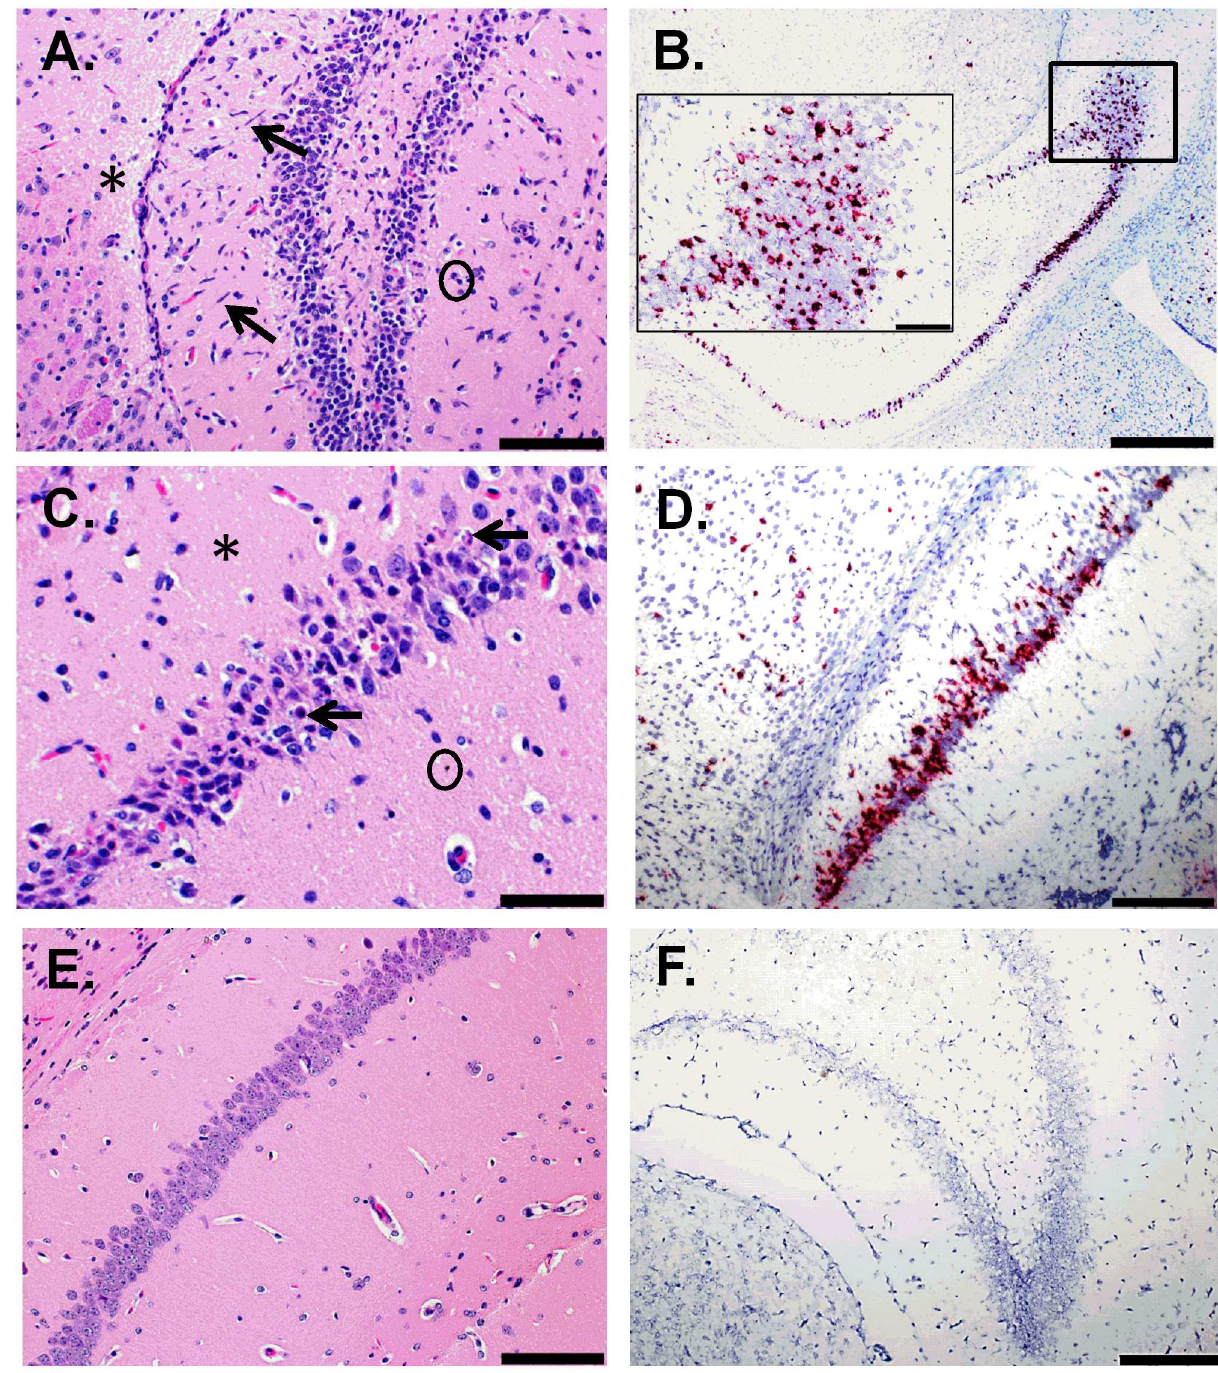
Fig 4. Histologic and ISH Findings in the Hippocampus of ZIKV-Infected Wild-type Mice Treated with an IFNAR1-Blocking MAb and Uninfected Control Mice. (A) The hippocampus of a mouse exposedto ZIKV intraperitoneally(IP) that was euthanized on day 11 post- infection(PI). Representative hematoxylin and eosin stainingshowedneuropilvacuolation (representative area indicatedwith an asterisk), microgliosis (representative cells indicatedby arrows), and necrotic cellulardebris (representative area indicatedwith a circle); scale bar represents100 μ m. (B) The hippocampus of a mouse exposedto ZIKV IP that was euthanized on day 7 PI. The representative ISH staining demonstrates massive ZIKV infectionof the brain; scale bar represents500 μ m (inset picture scale bar represents 100 μ m). (C-D) The hippocampus of a mouse exposed to ZIKV IP that was euthanized on day 7 PI. (C) The representative hematoxylinand eosin staining demonstrates that pyramidal neuronsare often necrotic (representative cells indicatedby arrows) and the adjacentvacuolatedneuropil